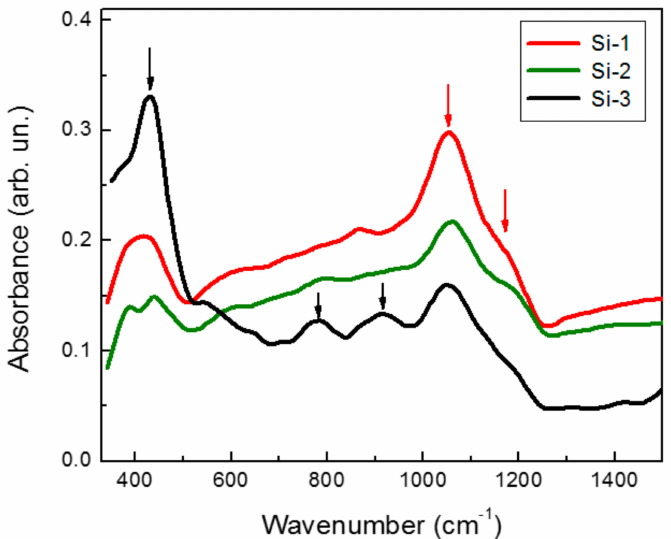
Figure 4. Fourier transform infrared (FTIR) absorbtion spectra of laser-ablated samples obtained at di ff erent ratio of helium to nitrogen pressures. Vertical red and black arrows indicate the spectral position of the Si-O and Si-N bonds,